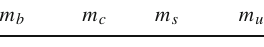
Table 1 Quark mass and the parameter β (in units of GeV)